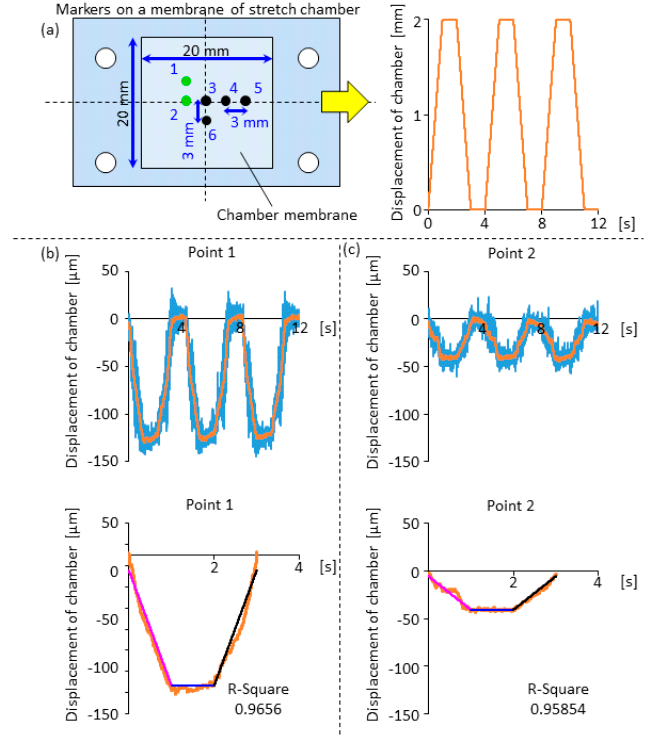
Figure 6. Vertical displacement trajectories of targets on the chamber membrane exposed to a stretching waveform different from that in Figures 4 and 5. ( a ) Layout of targets on the chamber membrane and the waveform for the control of stage 1/chamber stretching. ( b ) and ( c ) Upper: a typical waveform of points 1 and 2 when the chamber was stretched. Lower: the fit results of the stretching/holding/relaxation phases of the corresponding upper waveform. In ( b ) and ( c ), original data is in light blue and filtered data in orange. The lines with color in purple, blue, and black are the lines fitting for the lengthening, holding, and relaxation phases, respectively.